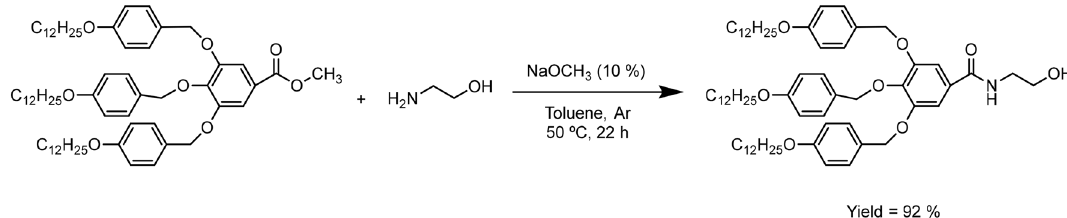
Figure 2. Synthesis of N -(2-hydroxyethyl)-3,4,5–tris(4-dodecyloxybenzyloxy) benzamide (TAPAm).